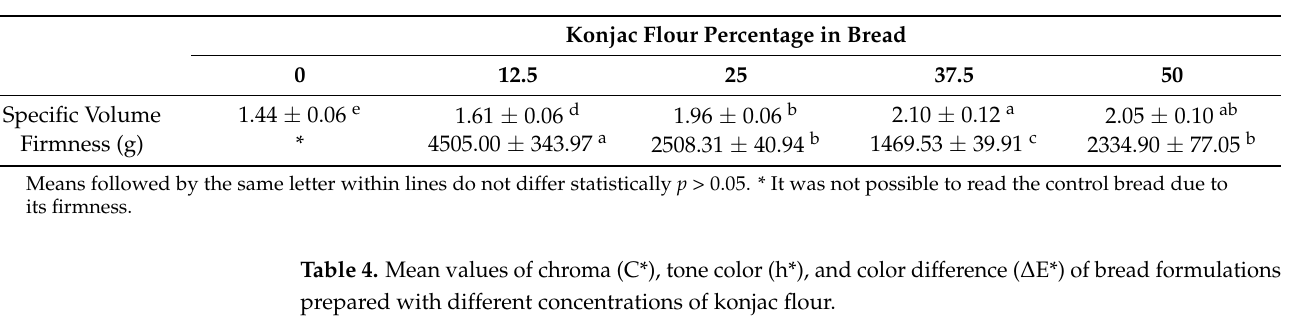
Table 3. Specific volume and texture of bread formulations prepared with different concentrations of konjac flour.